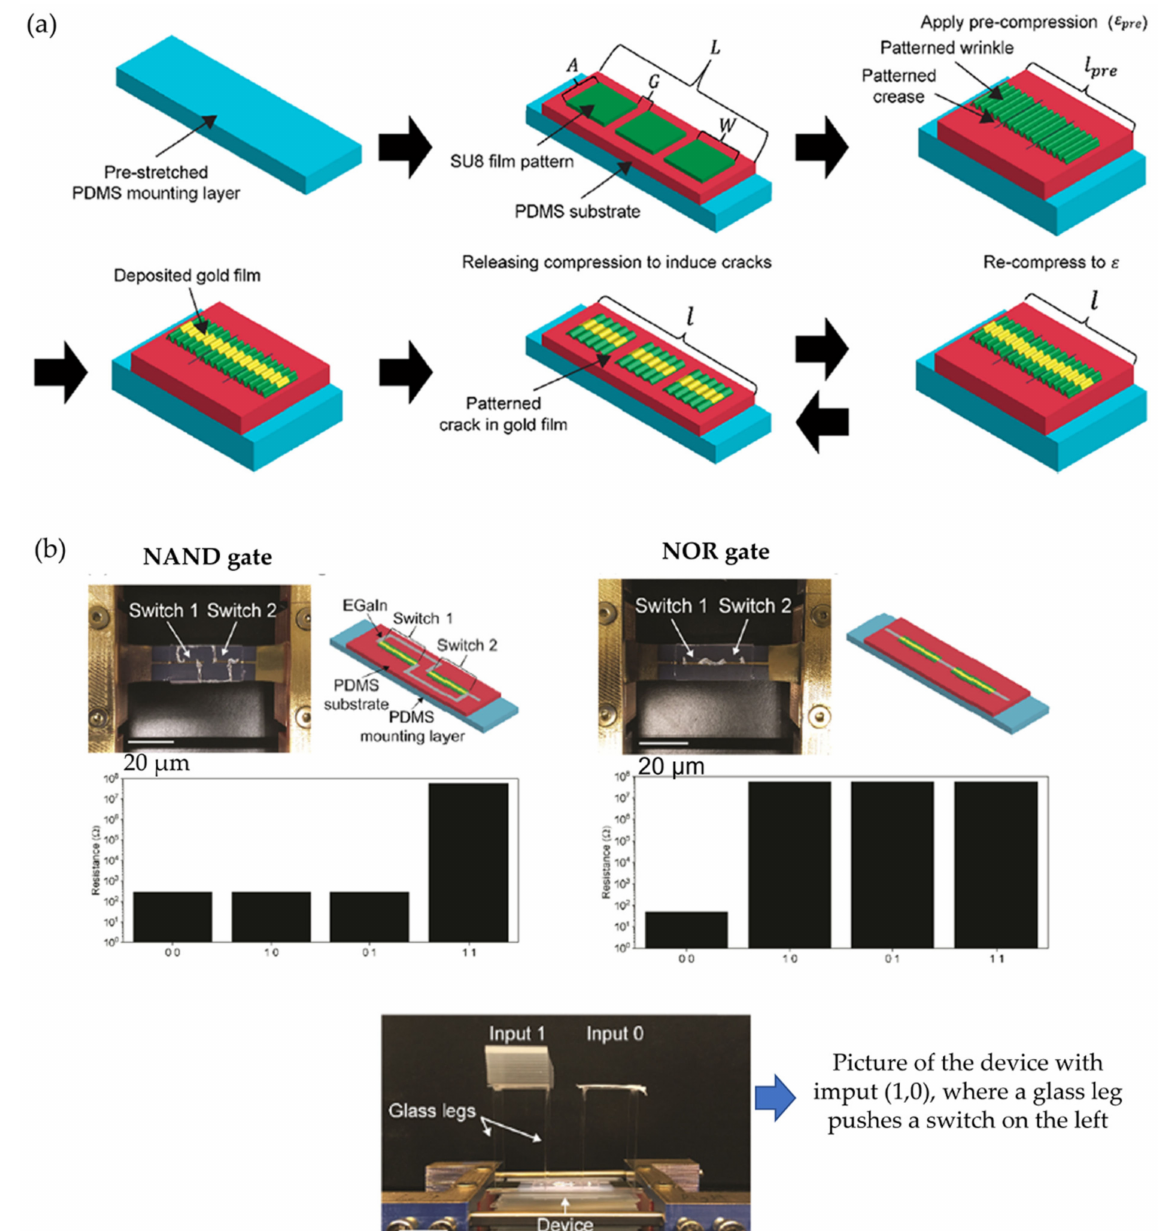
Figure 19. ( a ) Schematic representation of the strategy used to fabricate switchable surfaces. ( b ) Mechanical logic gates (NAND gates, NOR gates). The final image of the device is presented with an input of (1,0), where a glass leg pushes a switch to the left. Reproduced with permission from reference [76]. Copyright 2020, American Chemical Society